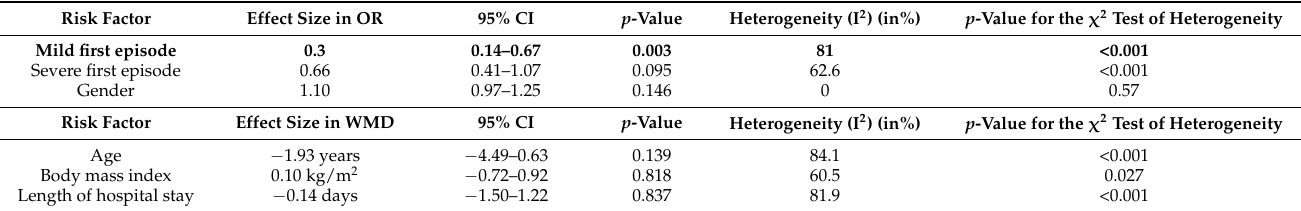
Table 2. Results of the analyses on risk